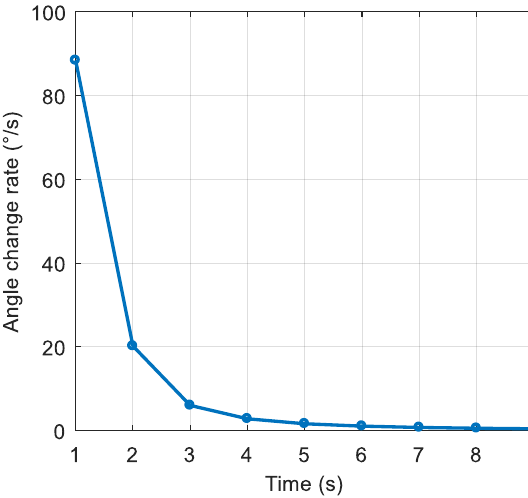
Figure 13. The rate of change of the interference arrival angle.